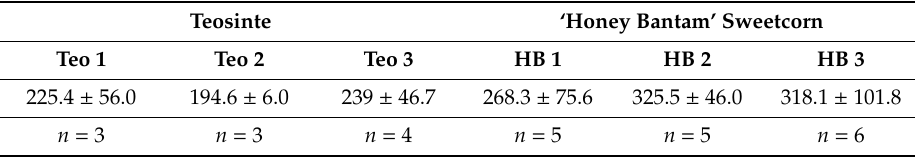
Table 3. Mean ( ± std. dev.) LMX cell cross-sectional area ( µ m 2 ) at approximately 100 µ m from the RCJ. Table 3. Mean (± std. dev.) LMX cell cross-sectional area (µm 2 ) at approximately 100 µm from the The di ff erence between taxa was not statistically significant. RCJ. The difference between taxa was not statistically significant.